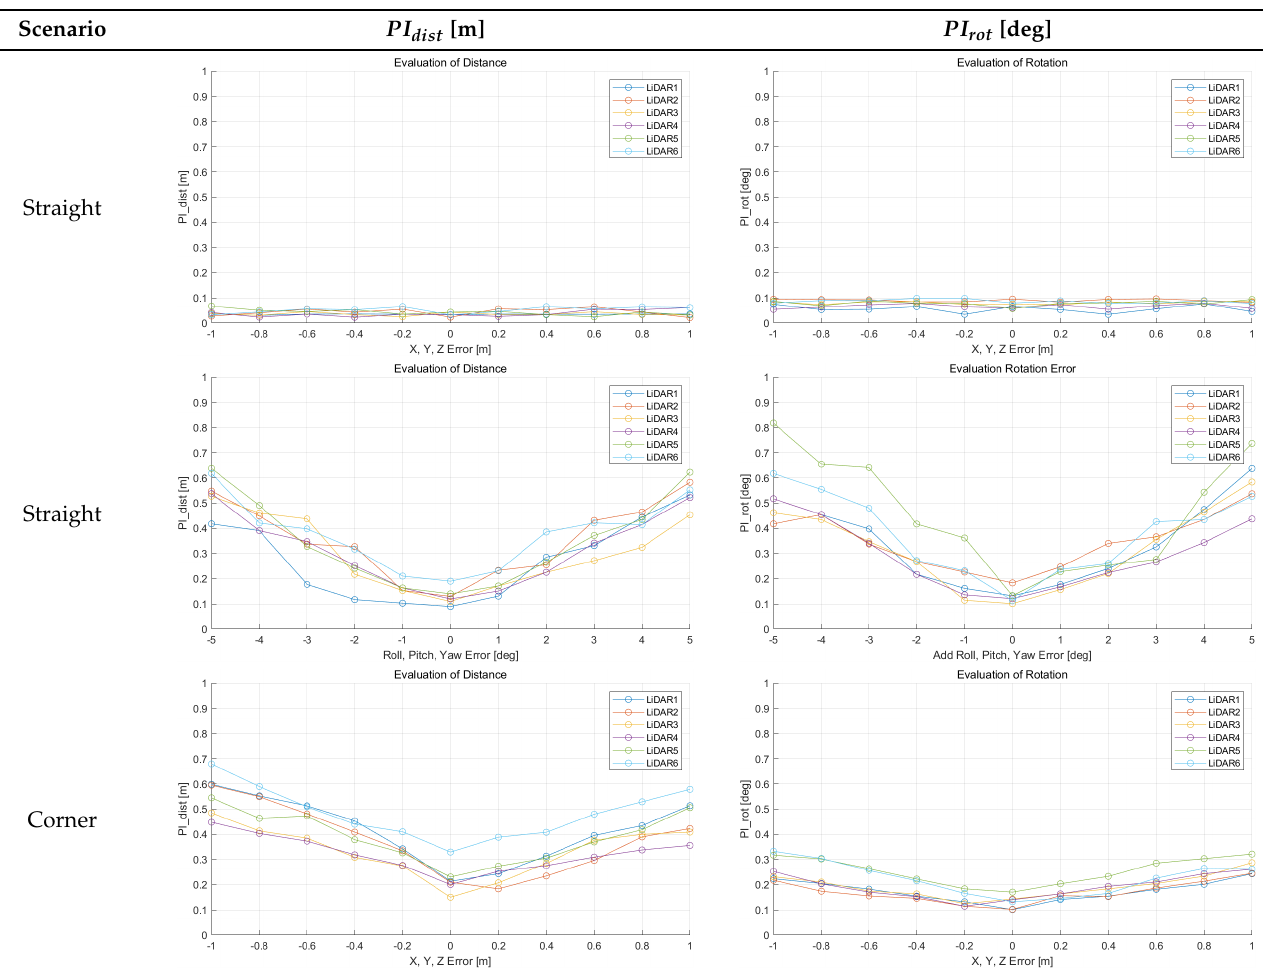
Table 5. Result of experiment using simulation